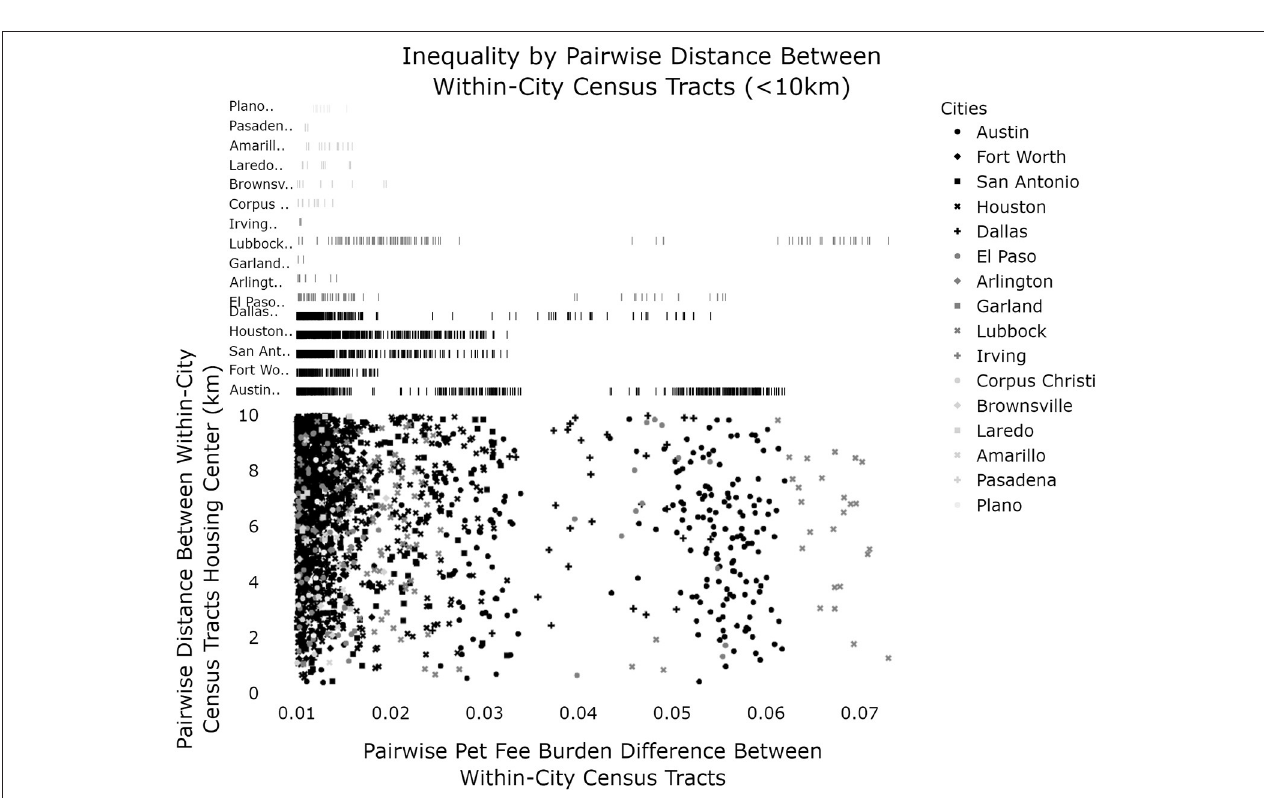
FIGURE 3 | Relationship between relative pet fee burden difference by spatial distance by census tract. Pairs of census tracts within cities that are < 10km apart (from housing centroids) are compared and clear, city-wise stratification can be seen with Austin and Lubbock as the clear